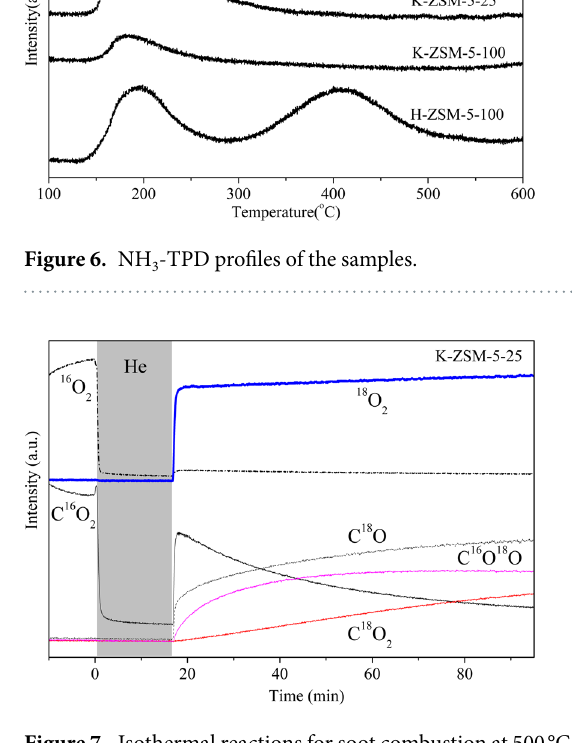
Figure 7. Isothermal reactions for soot combustion at 500 °C after 1% 16 O 2 was switched to 1% 18 O 2 in He on